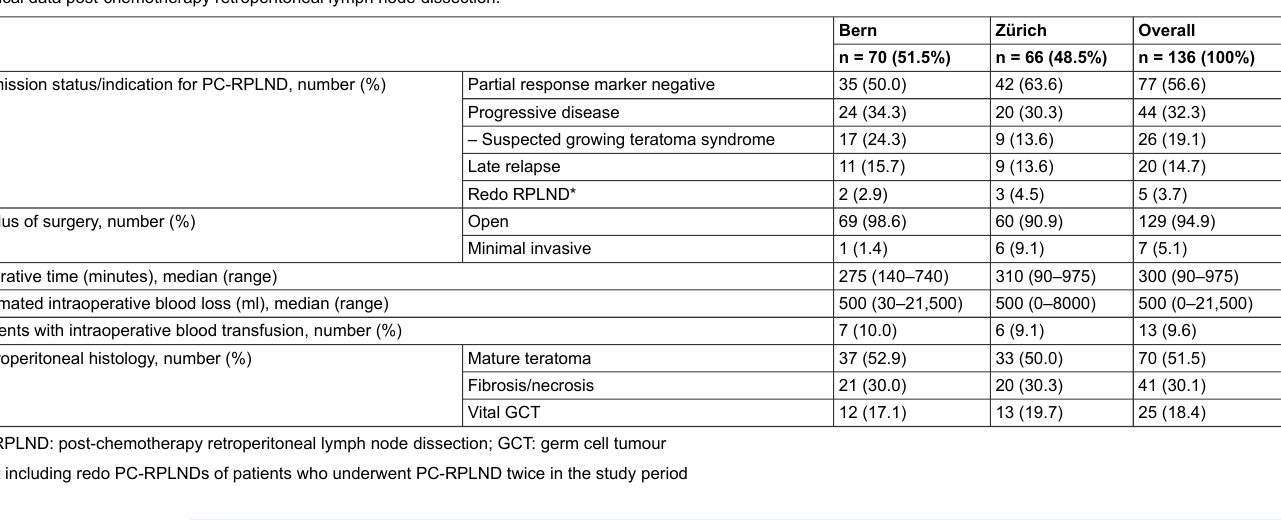
Bern Zürich Overall n = 70 (51.5%) n = 66 (48.5%) n = 136 (100%)